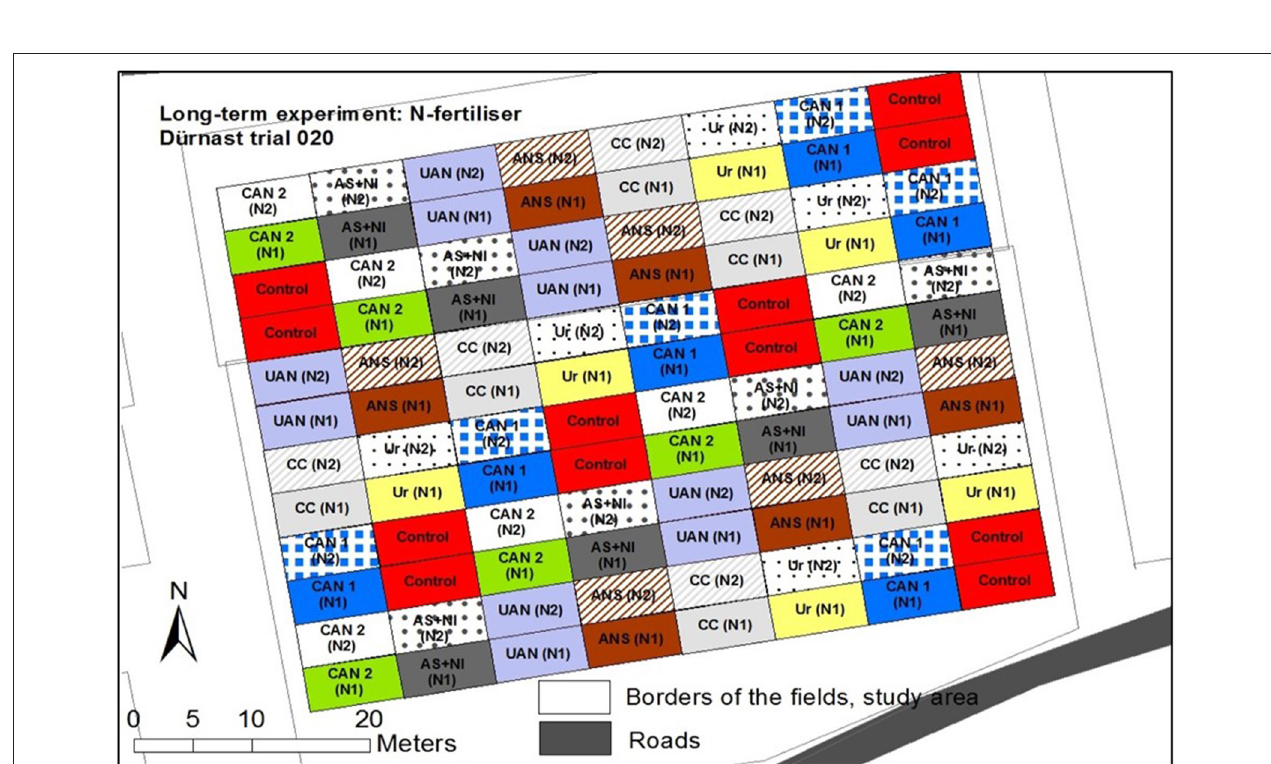
FIGURE 2 | Arrangement of the experimental area with the distribution of the N-fertilizer forms (abbreviations, see Table 2 ) and the level of fertilization [low (N1), high (N2)].